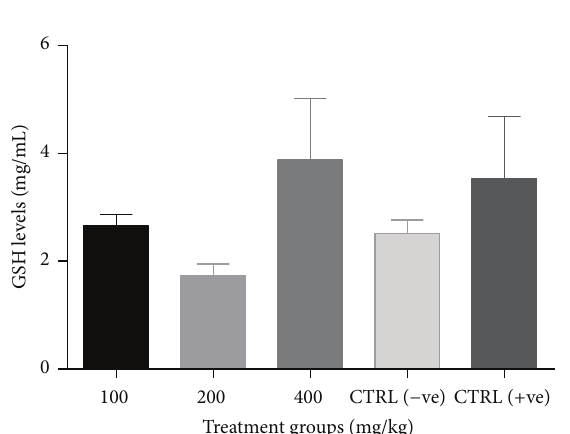
Figure 4: Effect of combined extracts of Azadirachta indica and Khaya senegalensis on glutathione (GSH) levels of the intestine of chickens infected with Eimeria oocysts.